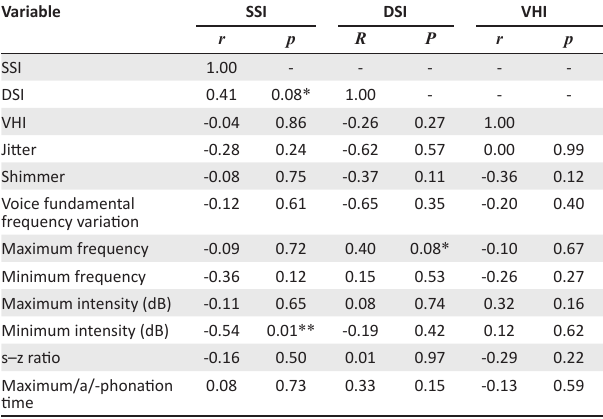
TABLE 6: Acoustic outcomes and correlations between the stuttering severity instrument, Dysphonia Severity Index and Voice Handicap Index and acoustic variables.